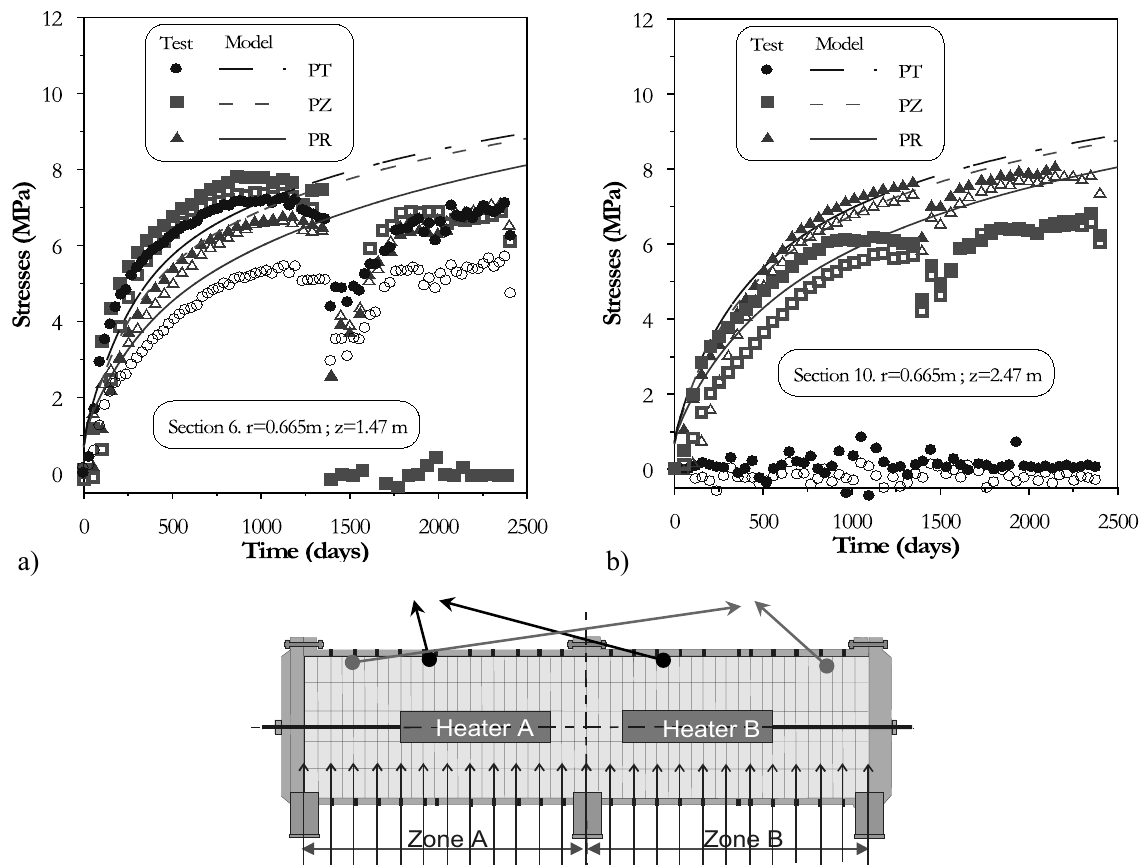
Fig. 10 – Evolution of stresses in the mock-up test. a) Sections A6-B6, and b) A10-B10. Observed versus computed values (OBC